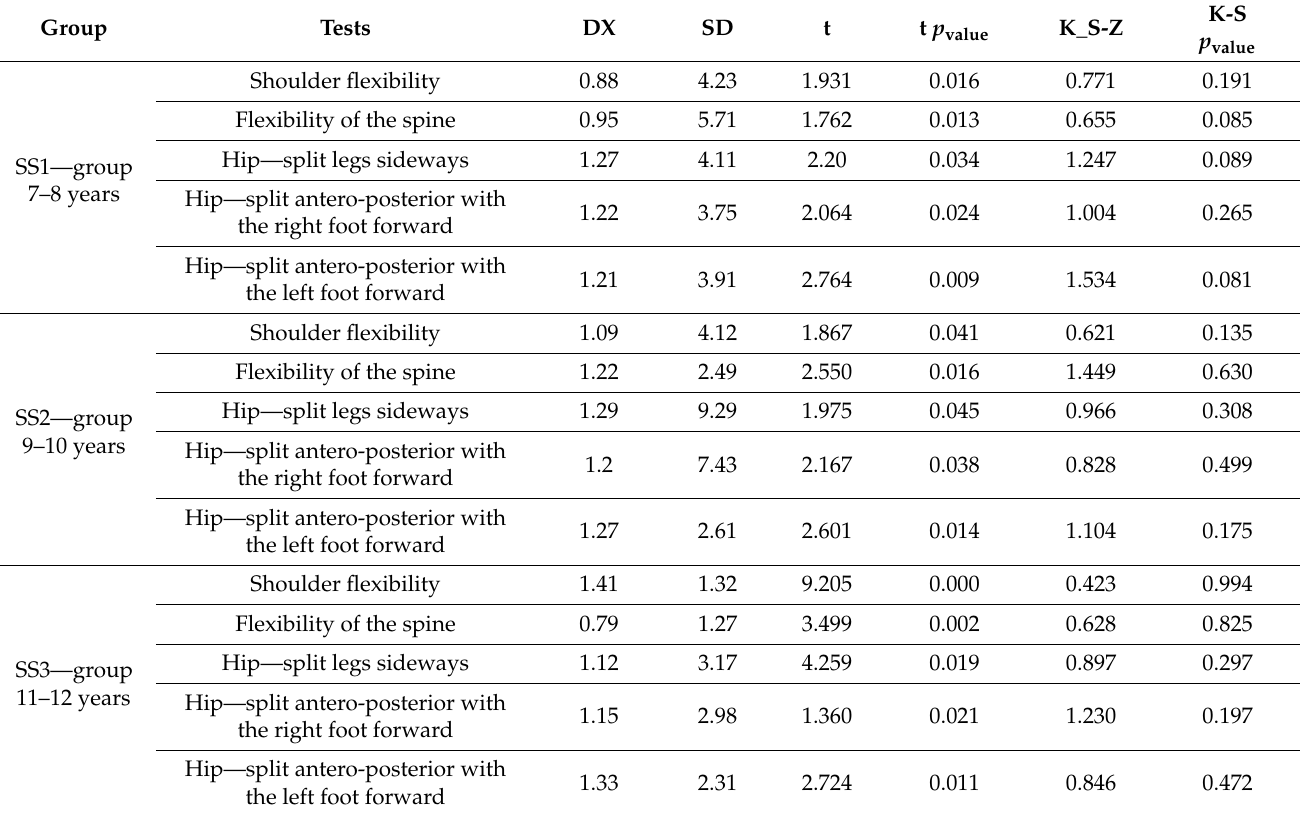
Table 5. Statistical description of differences of the averages of the groups between initial and final